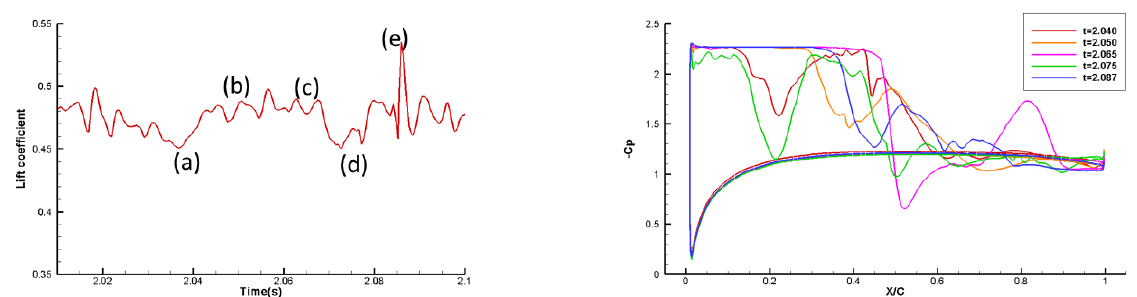
Figure 7. Variation of lift coefficient ( left ) and distribution of pressure coefficient ( right ) of LES model according to time series ( a is at t=2.040, b is at t=2.050, c is at t=2.065, d is at t=2.075, e is at t=2.087).